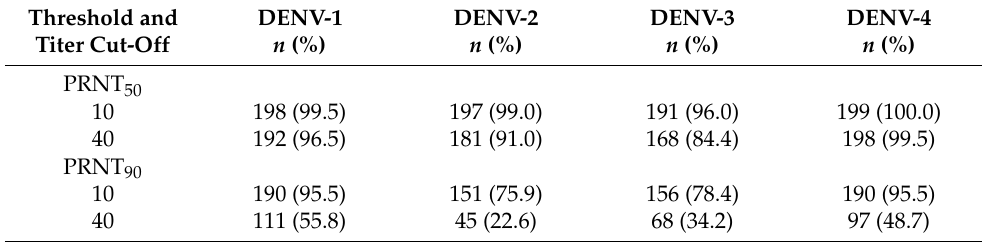
Table 1. Proportion of DENV NAb-positive sera at different thresholds ( n = 199).